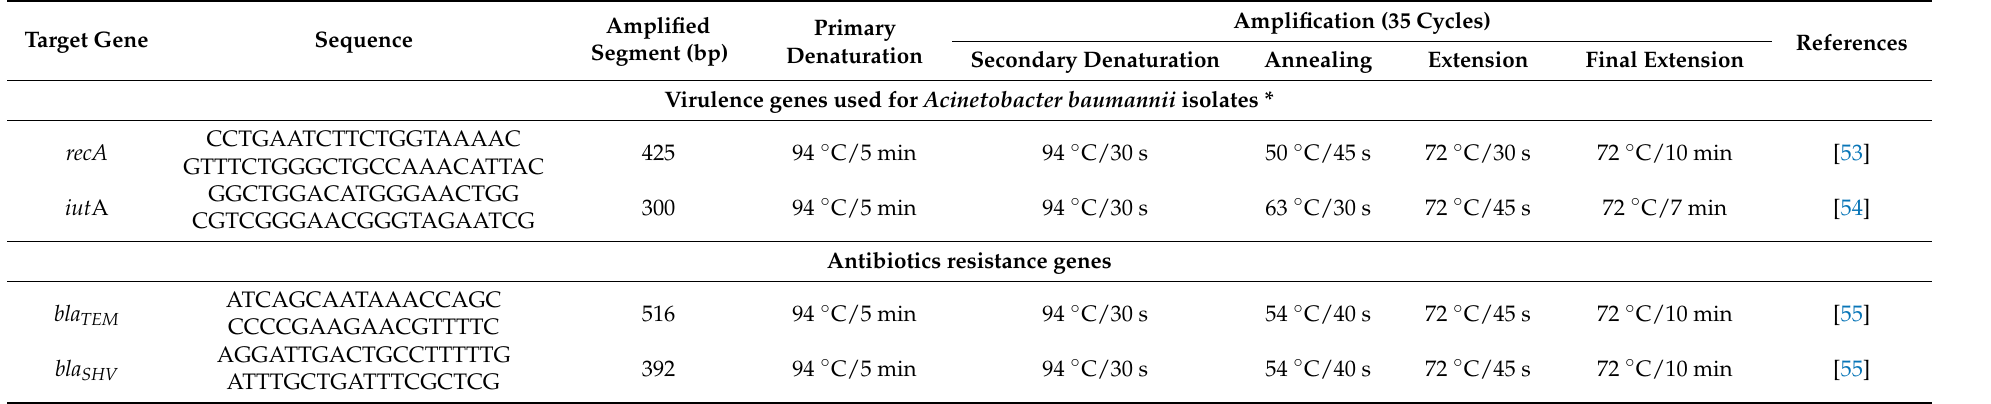
Table 5. Primers sequences, target genes, amplicon sizes, and cycling